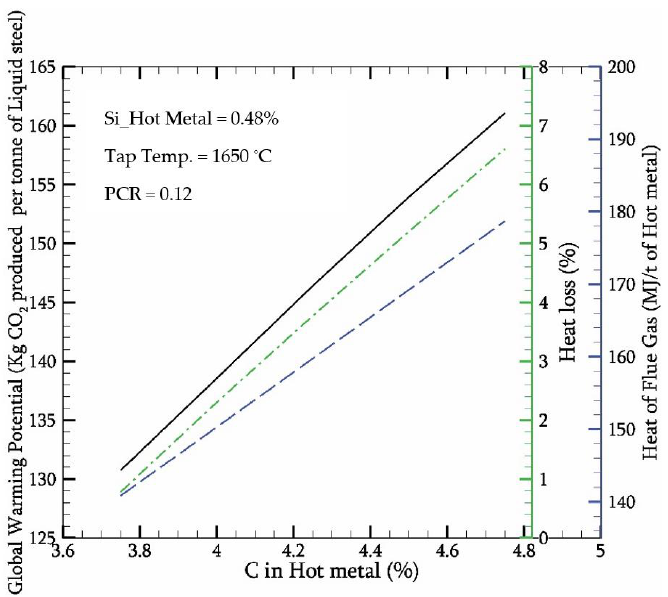
Figure 2. Effect of C in hot metal on GWP, heat loss, and heat of flue gas.